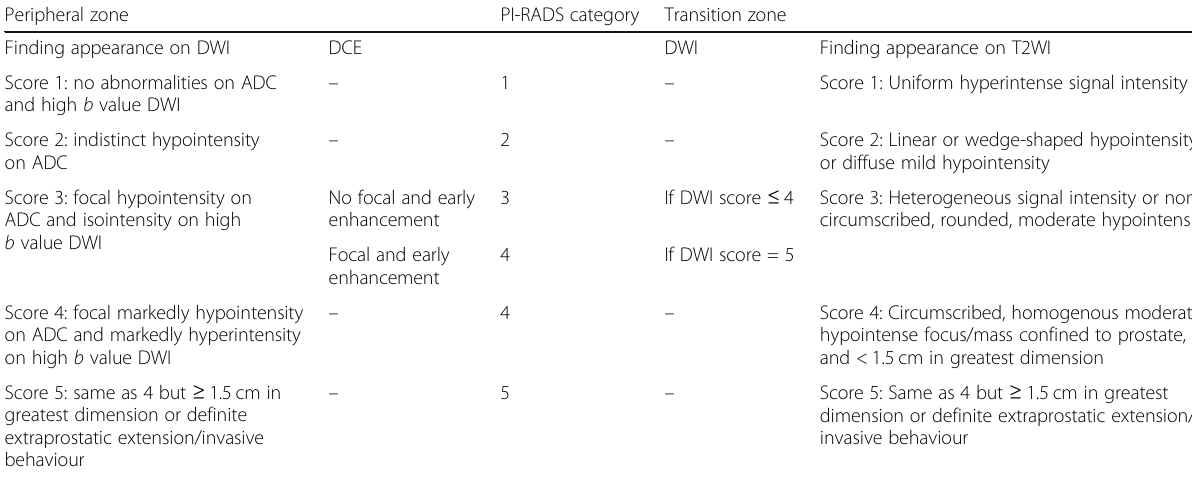
Table 1 PI-RADS version 2 interpretation rules for mpMRI to detect csPCa Peripheral zone Finding appearance on